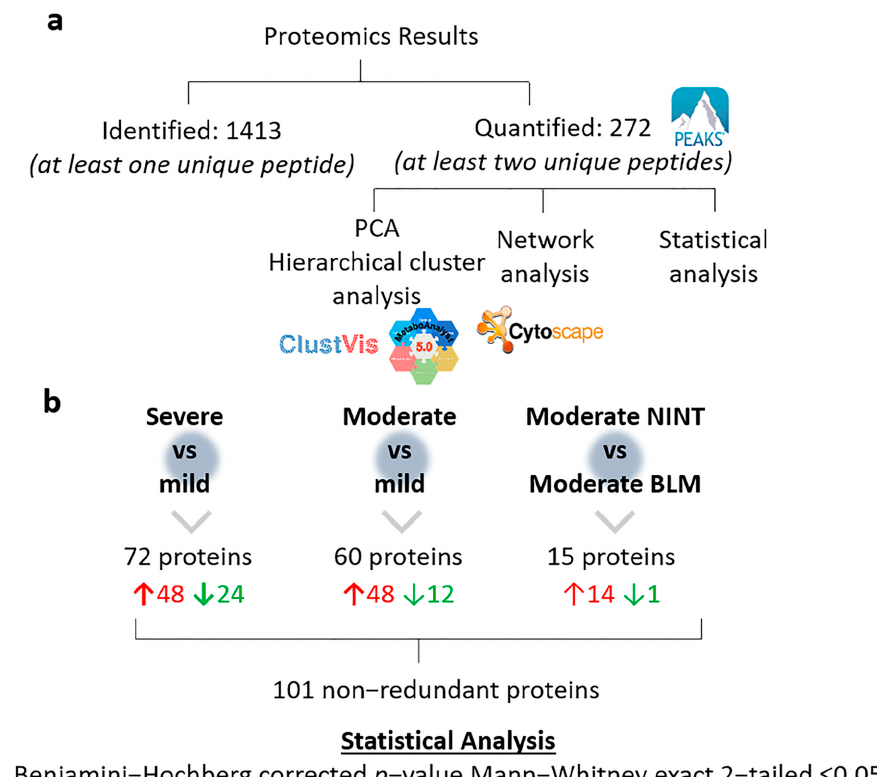
Figure 2. Summary of proteomics results. ( a ) Total numbers of identified and quantified proteins and further data elaboration steps. ( b ) Results of the statistical analysis following pairwise comparisons. PCA—principal component analysis; NINT: nintedanib; and BLM: bleomycin.